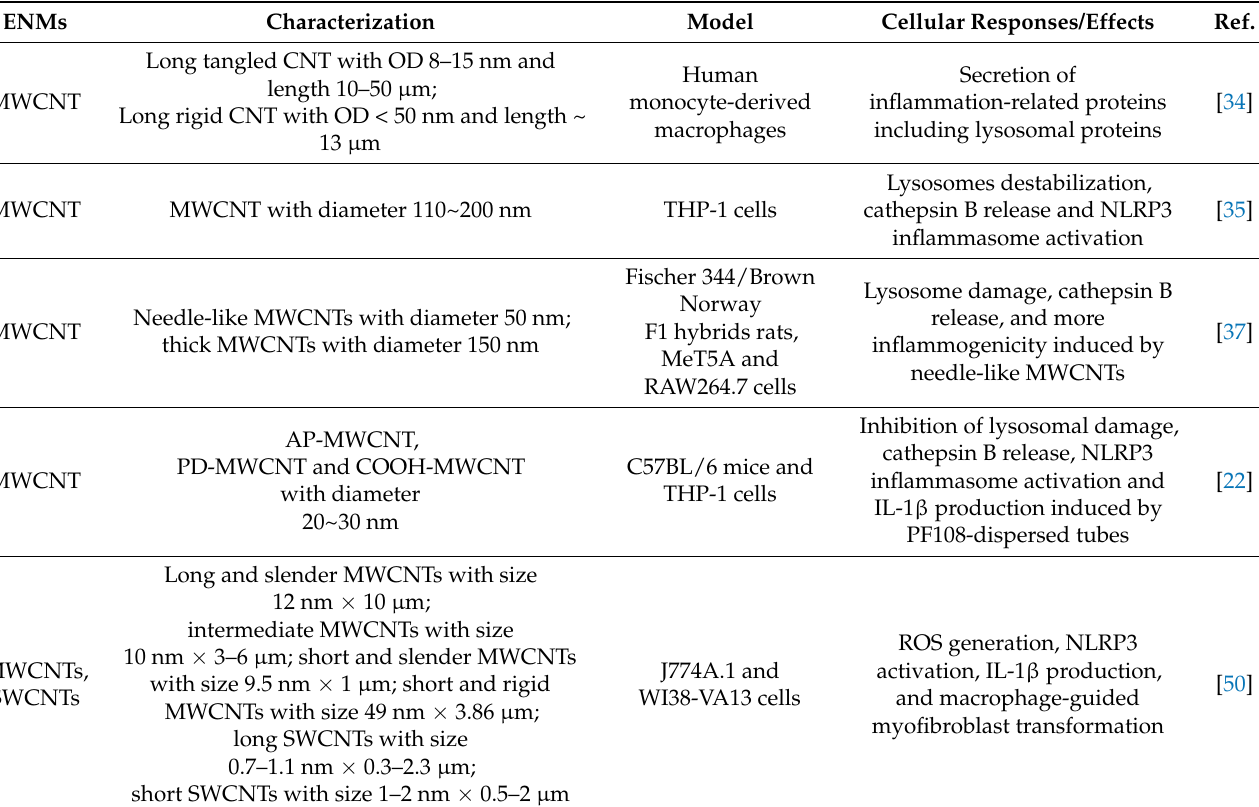
Table 1. Mechanisms involved in NLRP3 inflammasome activation by